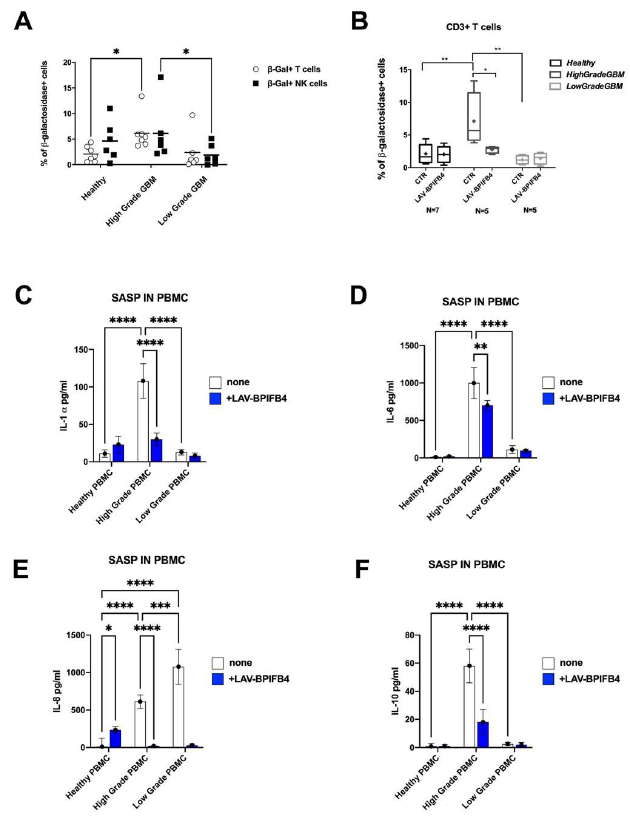
Figure 4. Immune senescence profile of PBMCs from GBM patients. ( A ) Results of the FACS analysis of Spider-β galactosidase in CD3+ T cells and CD3-CD56+ NK cells compartment among total PBMCs from GBM patients ( low and high grade) and healthy control, for comparison. ( B ) Analysis of the effects of 48 h LAV-BPIFB4 treatment (18 ng/mL) on the percentage of Spider-βGal+ CD3+ T cells among total PBMCs from healthy donors, high- and low- grade GBM patients. High- grade GBM patients had more senescent CD3+ T cells then healthy or low -grade patients. The treatment with rhLAV-BPIFB4 could restore the profile of peripheral immune cells. Statistical analysis by two-way ANOVA with Tukey’s test for multiple comparison was conducted. (* p < 0.01, ** p < 0.001, *** p < 0.0001, **** p < 0.00001). ( C – F ) Secretory profile of PBMC from GBM patients ( low and high grade) and healthy control after 48 h treatment with 18 ng/mL of rhLAV-BPIFB4 as detected by multiplex ELISA of the cell medium. Statistical analysis by two-way ANOVA with Tukey’s test for multiple comparison was conducted (* p < 0.01, ** p < 0.001, *** p < 0.0001, **** p < 0.00001). Of note, concerning the NK cell compartment, LAV-BPIFB4 was able to rescue the expression of the natural cytotoxicity receptor (NCR) NKp44 upon co-stimulation with interleukin (IL)-2. Indeed, in our cohort, the surface levels of NKp44, the only “inducible” receptor instrumental to immunosurveillance, were found downregulated in high-grade